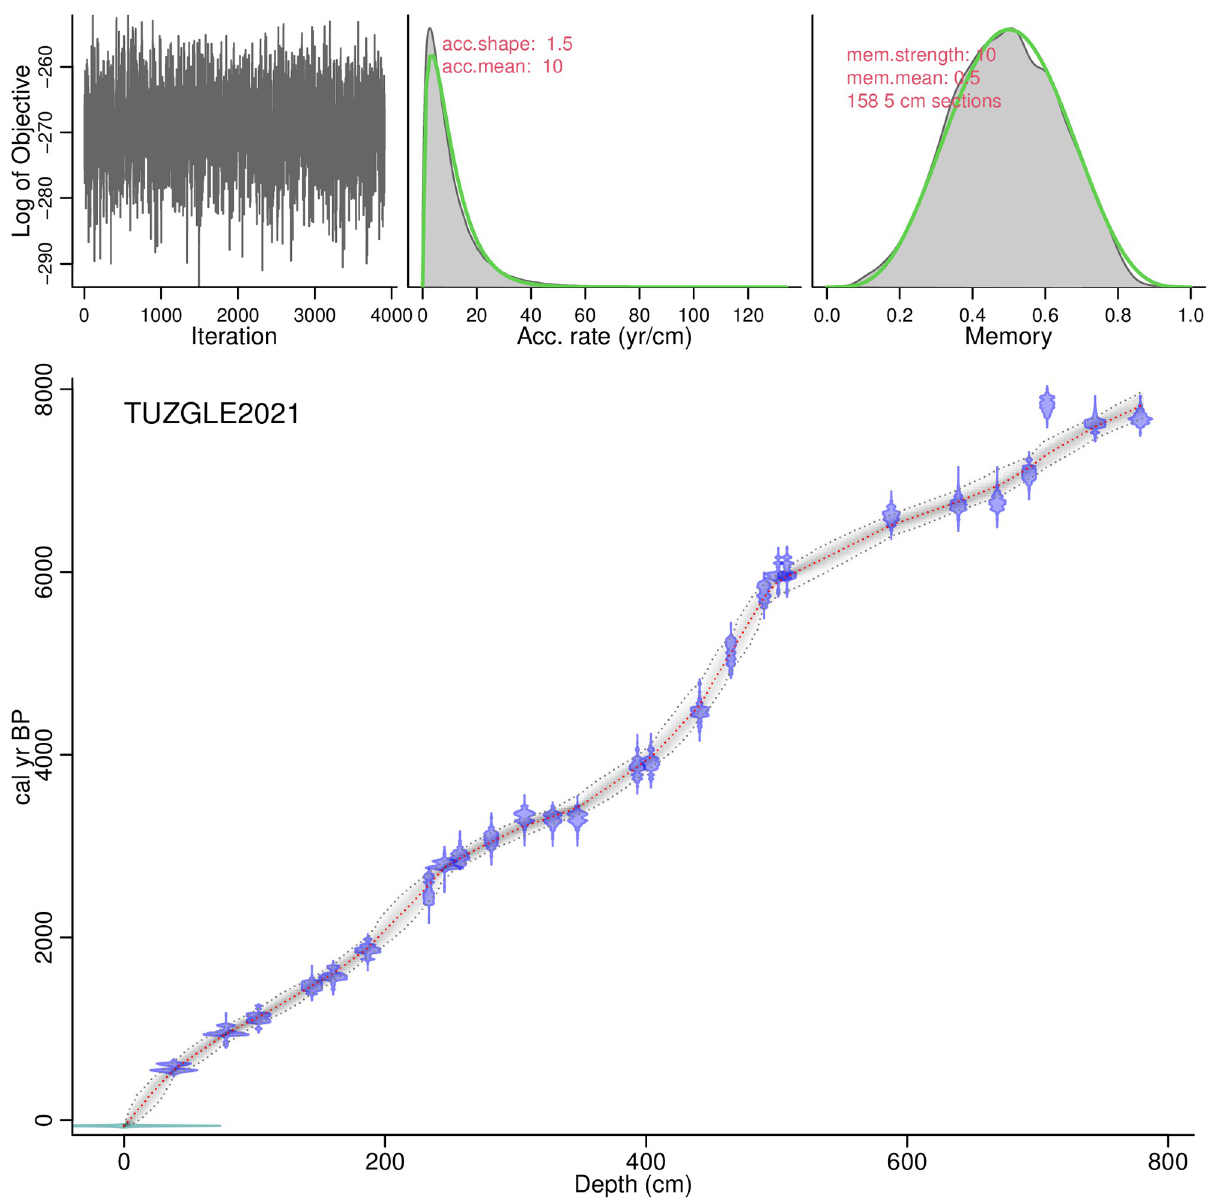
Fig 2. Bacon age-depth model for the CTP composite profile. Upper panels depict the Markov Chain Monte Carlo (MCMC) iterations (left), the prior (green curves) and posterior (grey histograms) distributions for the accumulation rate (middle panel) and memory (right panel). The bottom panel shows the calibrated 14 C dates (light blue) and the age-depth model (red curve) with 95% confidence intervals (grey dotted lines).